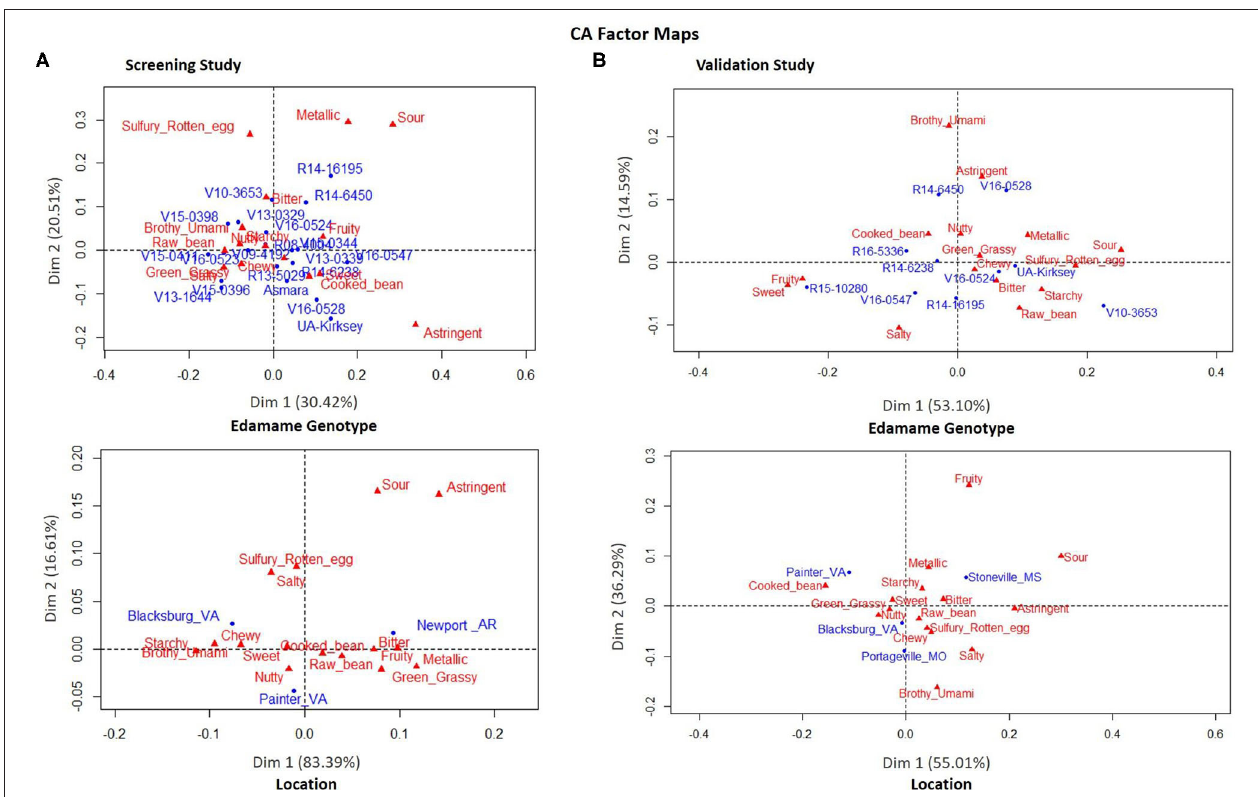
FIGURE 3 | Correspondence analysis (CA) factor maps for edamame genotypes and growing locations. (A) correspond to the screening study and (B) correspond to the validation study.